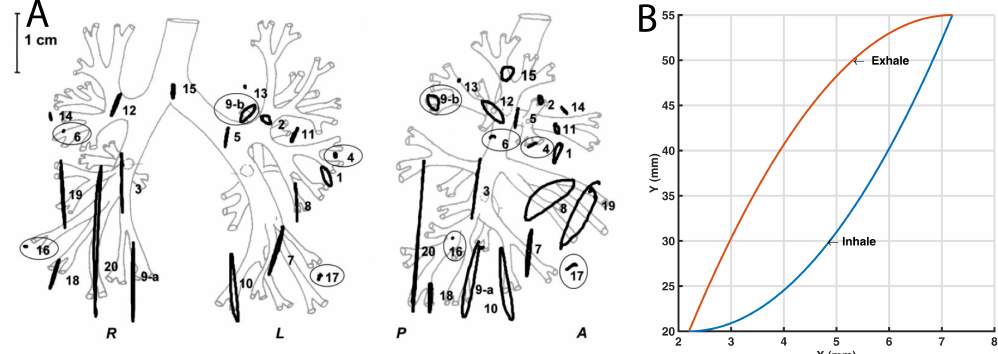
Figure 1. Hysteresis loop of lung tumors movement: ( A ) The orthogonal projections of the trajectories of the 21 tumors on (left) the coronal (LR-CC) and (right) the sagittal (AP-CC) plane is shown (reproduced with permission from [9]); and ( B ) One recreated hysteresis cycle that simulates the movement of the tumor is